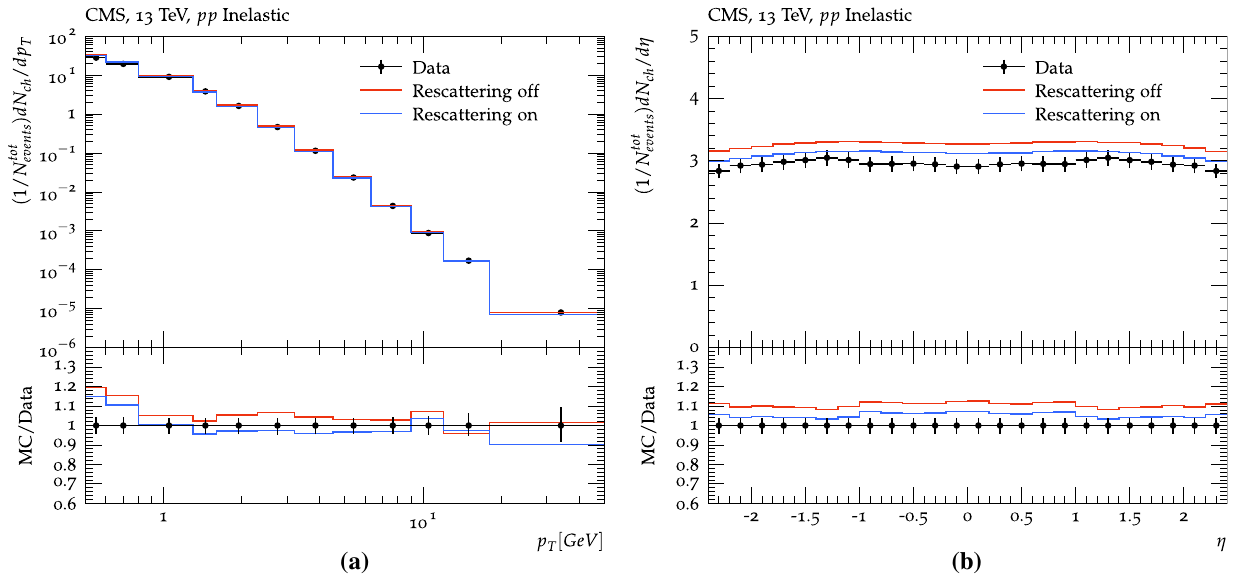
Fig. 18 p ⊥ and η spectra compared with data from CMS [78]. Charged particles with p ⊥ > 500 MeV and | η | < 2 . 4 are considered